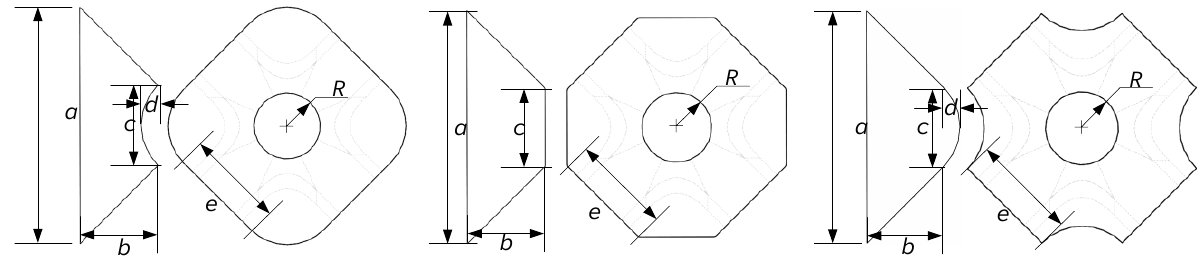
FIGURE 3. Rail-armature model with different configurations TABLE I. Electromagnetic launcher material parameters Materials Density / -3 kg m  （ ） Conductivity / -1 S m  （ ）